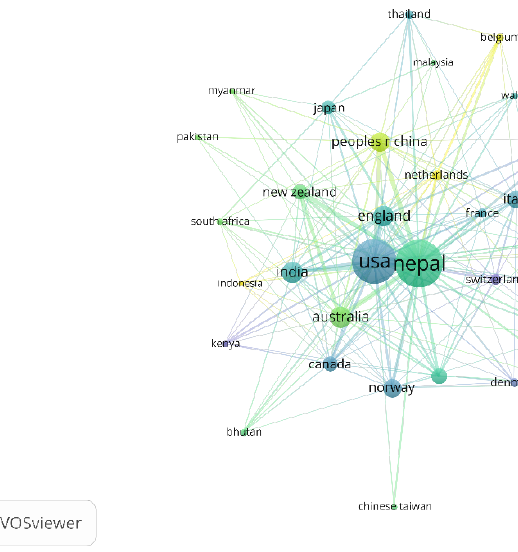
Figure 14. Overlay map of countries and regions.